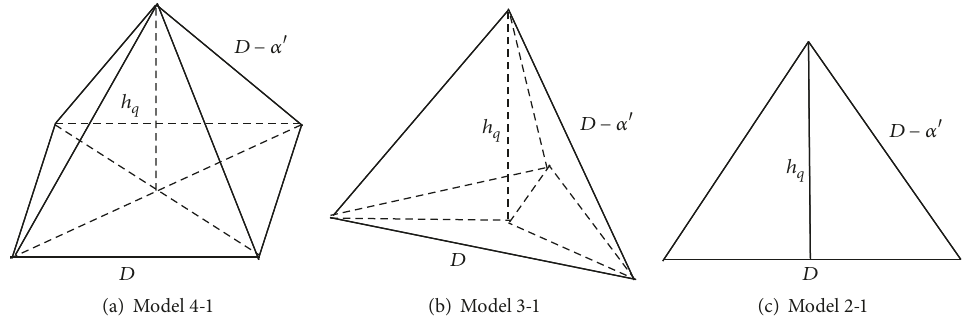
Figure 4: Simplified diagram under three arrangement modes.